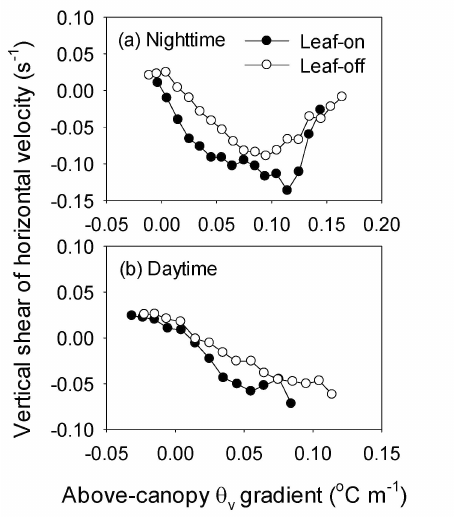
Figure 12. Changes of the vertical shear of horizontal wind speed between 42 and 48 m with the gradient of above- canopy virtual potential air temperature (θ v ) in the nighttime ( a ) and daytime ( b ) in